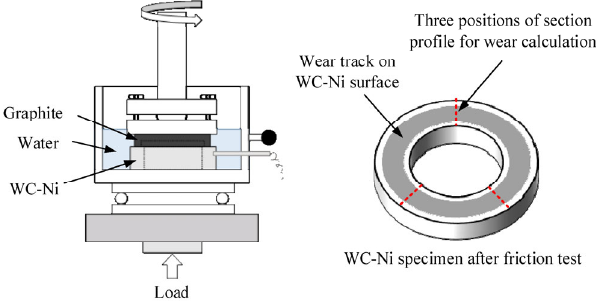
Fig. 2 Schematic of tribo-meter and the determination of wear volume.